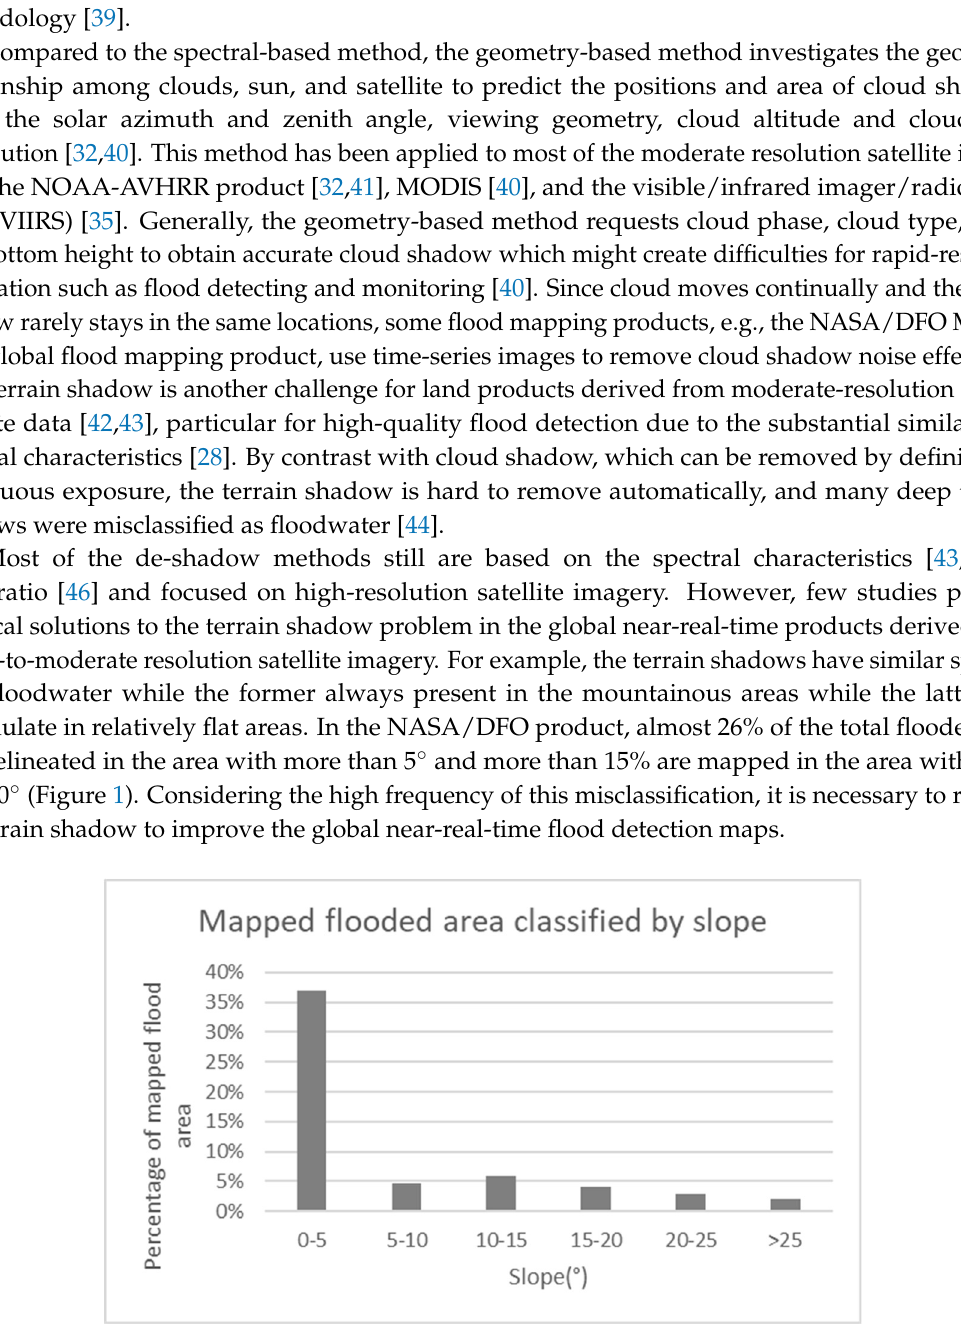
Figure 1. Mapped flooded area in the United States from 2011–2015 by National Aeronautics and Space Administration/Dartmouth Flood Observatory (NASA/DFO) near real-time (NRT) global flood product.